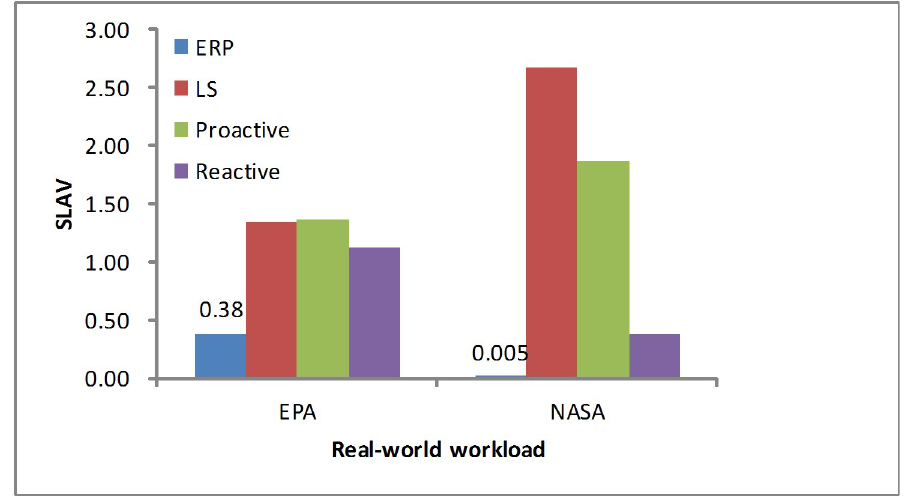
Fig 17. SLAV in the real-world workloads.